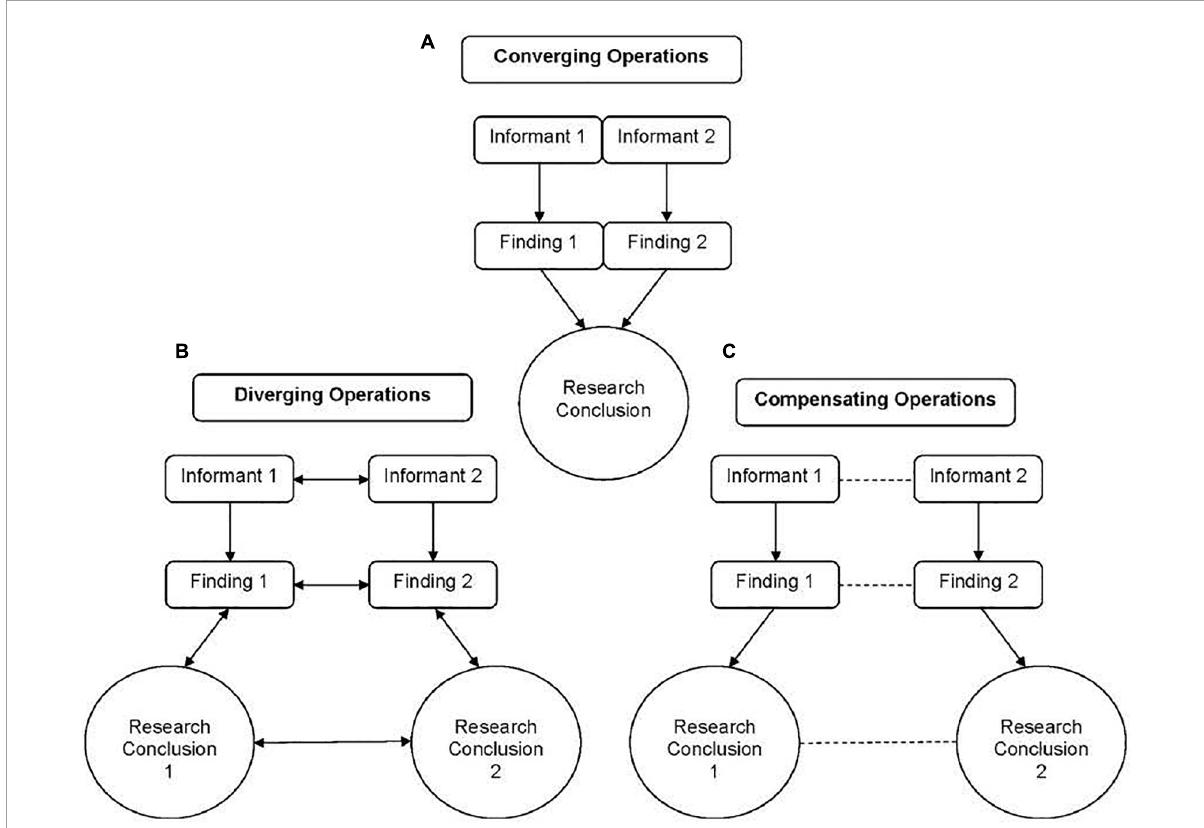
FIGURE3 Graphical representation of the research concepts that comprise the Operations Triad Model. The top half (A) represents Converging Operations: a set of measurement conditions for interpreting patterns of findings based on the consistency within which findings yield similar conclusions. The bottom half denotes two circumstances, within which researchers identify discrepancies across empirical findings derived from multiple informants’ reports and, thus, discrepancies in the research conclusions drawn from these reports. On the left (B) is a graphical representation of Diverging Operations: a set of measurement conditions for interpreting patterns of inconsistent findings based on hypotheses about variations in the behavior(s) assessed. The solid lines linking informants’ reports, empirical findings derived from these reports, and conclusions based on empirical findings denote the systematic relations among these three study components. The dual arrowheads in the figure representing Diverging Operations convey the idea that one ties meaning to the discrepancies among empirical findings and research conclusions and, thus, how one interprets informants’ reports to vary as a function of variation in the behaviors being assessed. On the right (C) is a graphical representation of Compensating Operations: a set of measurement conditions for interpreting patterns of inconsistent findings based on methodological features of measures or informants. The dashed lines denote the lack of systematic relations among informants’ reports, empirical findings, and research conclusions. Originally published in De Los Reyes et al. (2013a). ©Annual Review of Clinical Psychology. Copyright 2012 Annual Reviews. All rights reserved. The Annual Reviews logo and other Annual Reviews products referenced herein are either registered trademarks or trademarks of Annual Reviews. All other marks are the property of their respective owner and/or